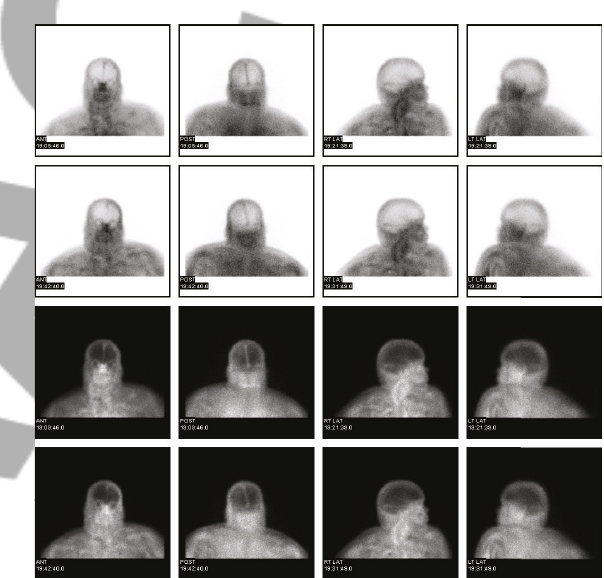
Figure 3: Patient #2. RCPS summative